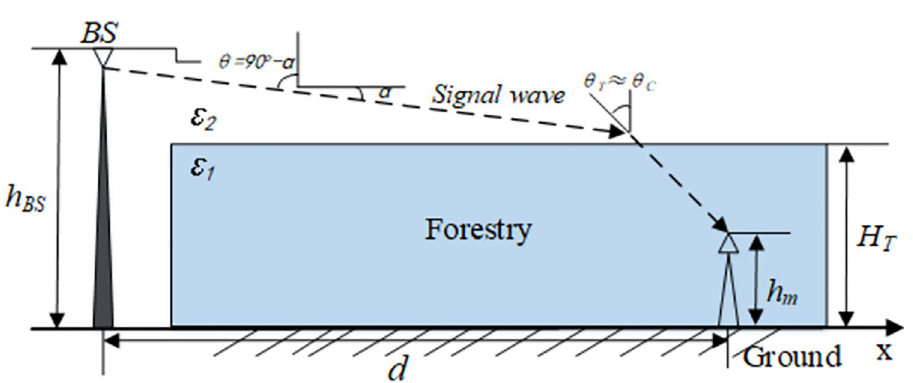
Fig 2. Prediction gain of vegetation paths with the base station in free